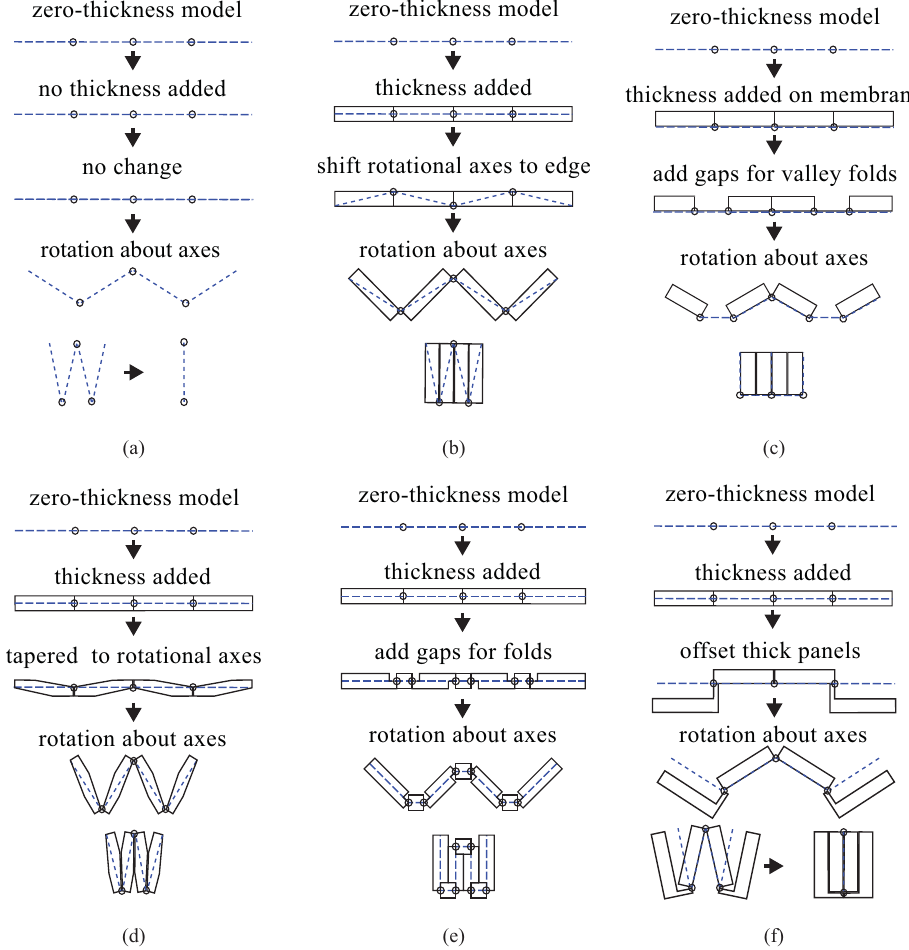
Figure 1. An illustration of the concepts of different thickness accommodation methods. All images, except (e) , are from Edmondson et al. (2014). (a) The zero-thickness model describes the basic kinematic behavior of the model. (b) The axis-shift method as demonstrated by Tachi (2011) shifts each rotational axis to either the top or bottom of the thick material. While slightly different conceptually, the method described by Hoberman (2010) can be illustrated identically. (c) The membrane folds method by Zirbel et al. (2013) mounts thick-material facets to a flexible membrane. (d) The tapered panels method from Tachi (2011) trims material from the panel edges to maintain the kinematics. (e) The offset crease technique, described by Abel et al. (2015), is similar to the membrane folds method, but calls for rigid material in the gaps between panels. This method was inspired by work done by Hoberman (1991) (f) The offset panel technique shown by Edmondson et al. (2014) offsets each panel from a selected joint plane and extends the rotational axes back to the joint